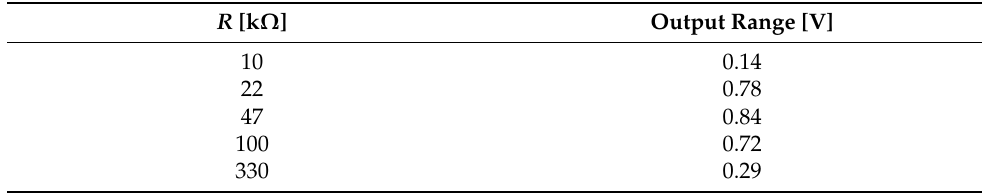
Figure 17. Analysis of resistance dimensioning: regression line of commercial sensor. Table 1. Analysis of resistance dimensioning: output range of commercial sensor.